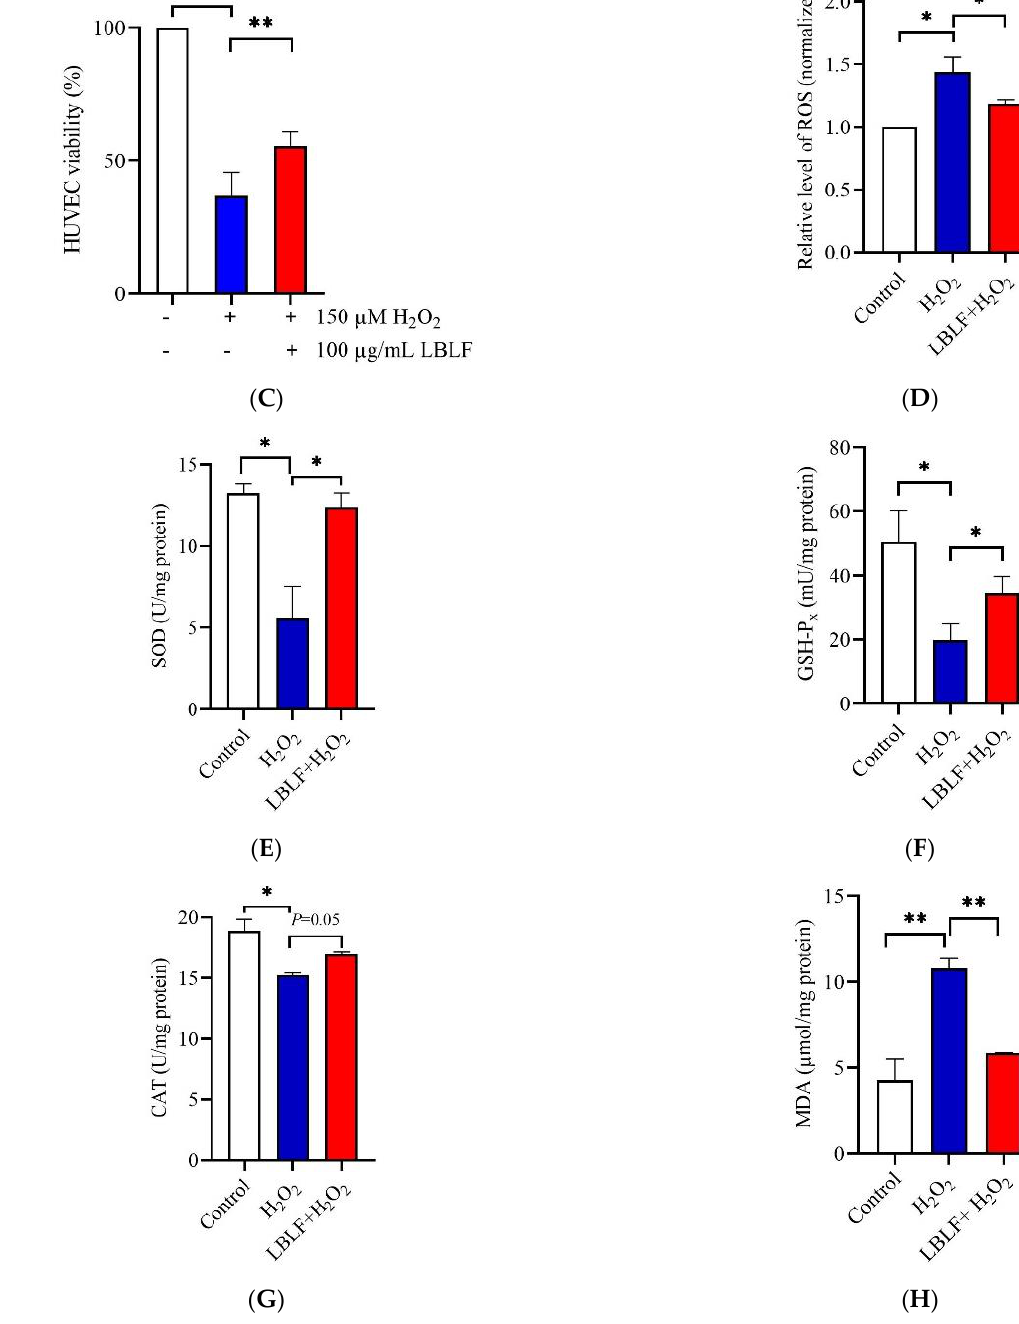
Figure 2. LBLF inhibits H 2 O 2 −indued injury in HUVECs by MTS assay. Effect of LBLF /H 2 O 2 on the proliferation of HUVECs ( A , B ). Survival rate of H 2 O 2 −induced injury following treatment with LBLF ( C ). Effects of LBLF on ROS ( D ), SOD ( E ), GSH−Px ( F ), CAT ( G ) and MDA ( H ) levels in H 2 O 2 −injured HUVECs. Values are presented as means ± SE, n = 3, # p < 0.05, ## p < 0.01 compared to the control group, * p < 0.05, ** p < 0.01 compared to the 150 μM H 2 O 2 group. White, blue, and red represent the control group (CK), 150 μM H 2 O 2 treatment group (HP), and 150 μM H 2 O 2 and 100 µg/mL LBLF cotreated group (LBLF), respectively.